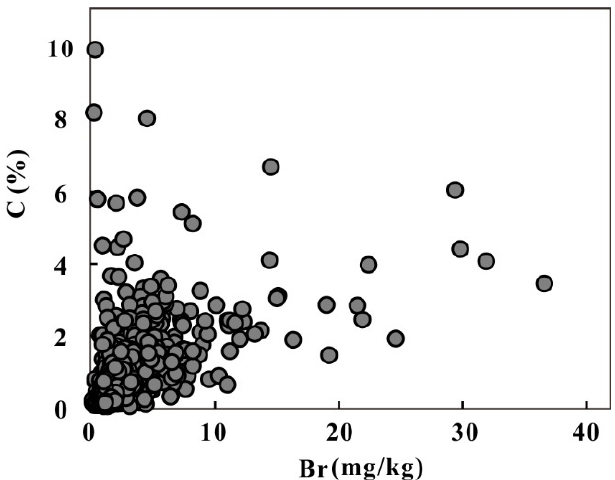
Figure 12. Correlation of C and Br contents in stream sediments from NGMPL.